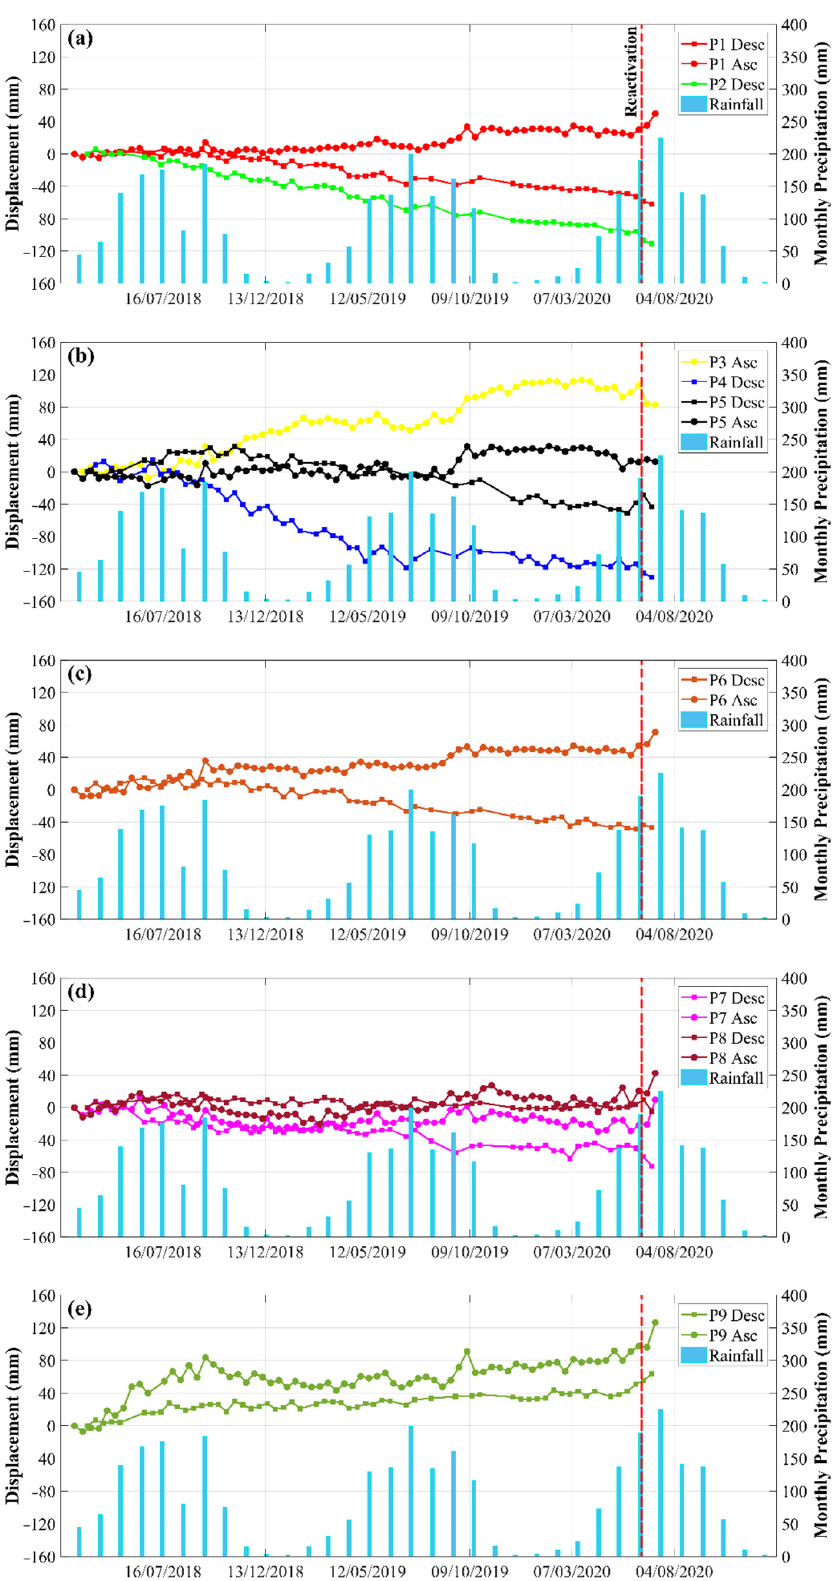
Figure 10. Pre-failure time-series plotting for selected measurement points from the different zones: ( a ) central zone (I); ( b ) landslide toe zone (II); ( c ) upstream zone (III); ( d ) landslide shoulder zone (IV); ( e ) unstable slope (V) zone in the pre-failure mean velocity map (Figure 8). Red dashed line indicates the reactivation of the ANZ